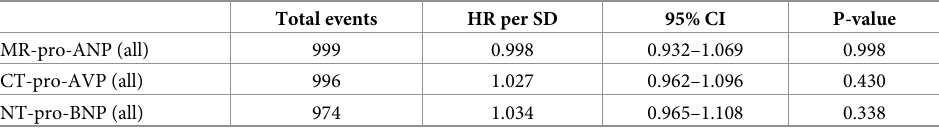
HR = hazard ratio. SD = standard deviation. See text for abbreviations of biomarkers. Models adjusted for age and gender. P-interaction for [gender (cid:3) MR-pro-ANP] on incident low energy fracture: 0.134; P-interaction for [gender (cid:3) CT-pro-AVP] on incident low energy fracture: 0.140; P-interaction for [gender (cid:3) NT-pro-BNP] on incident low energy fracture: